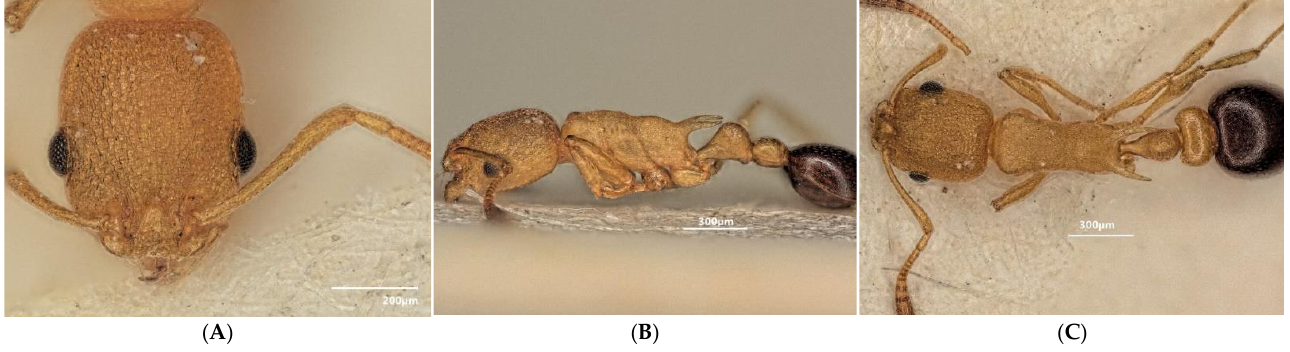
Figure 18. Cardiocondyla wheeleri , syntype: head in dorsal view ( A ), lateral view ( B ), dorsal view ( C ).